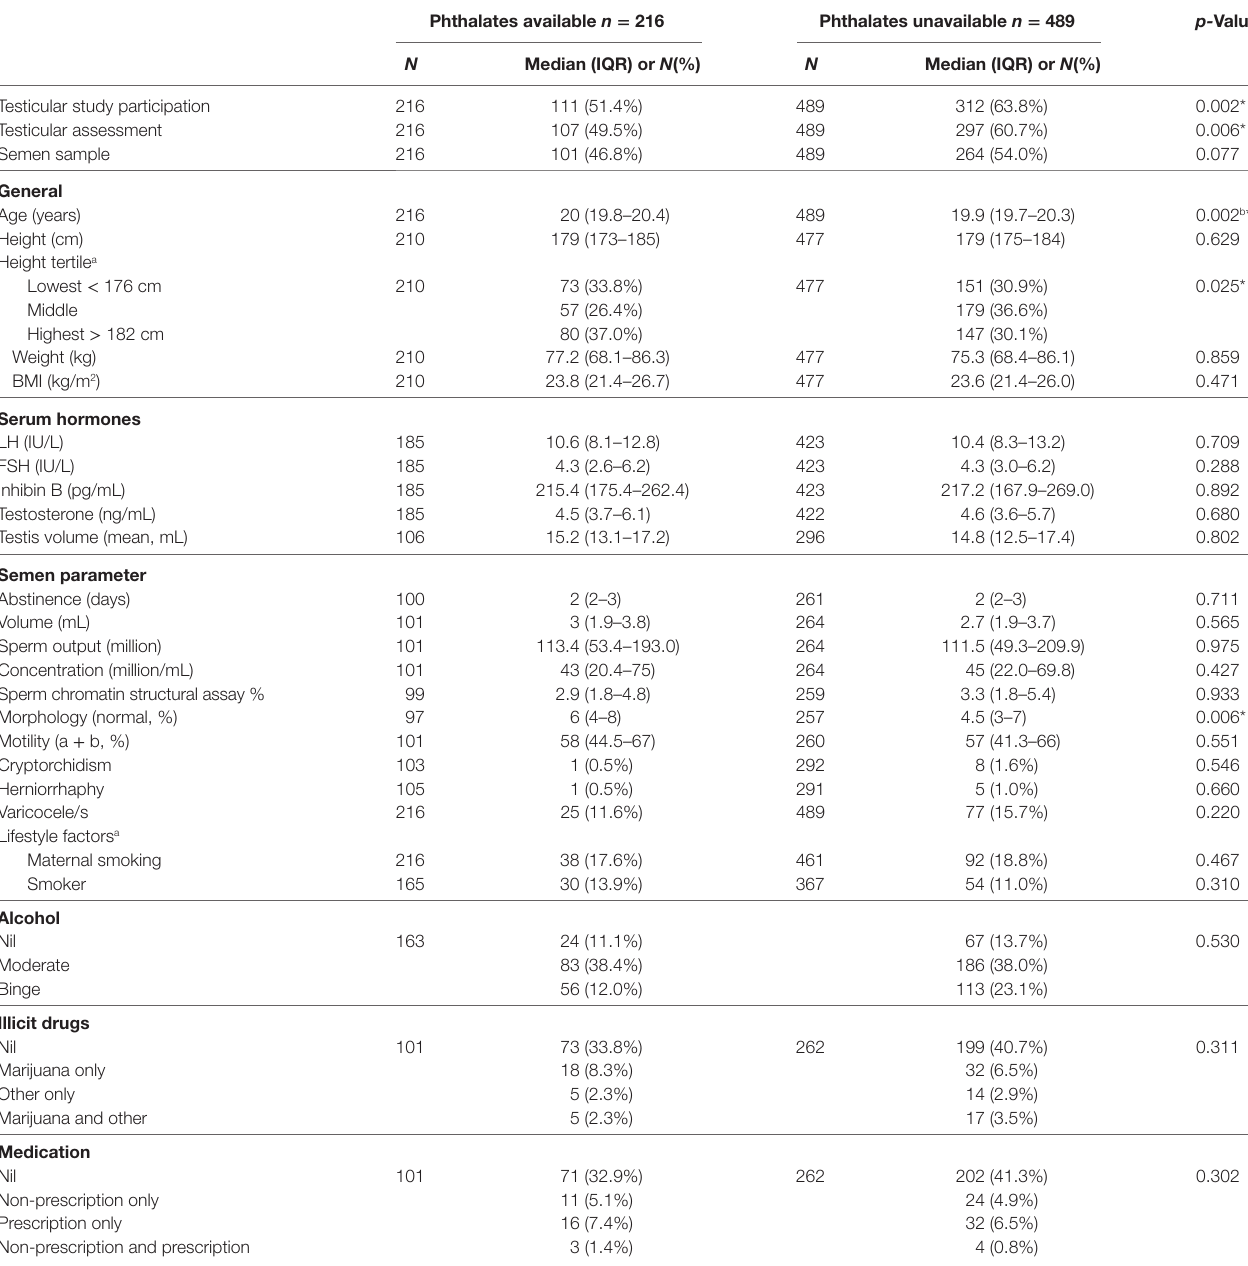
TaBle 3 | Anthropometric variables, lifestyle factors, and medical history of the male participants at 20 years of age—comparison between those with and without phthalates data available from maternal